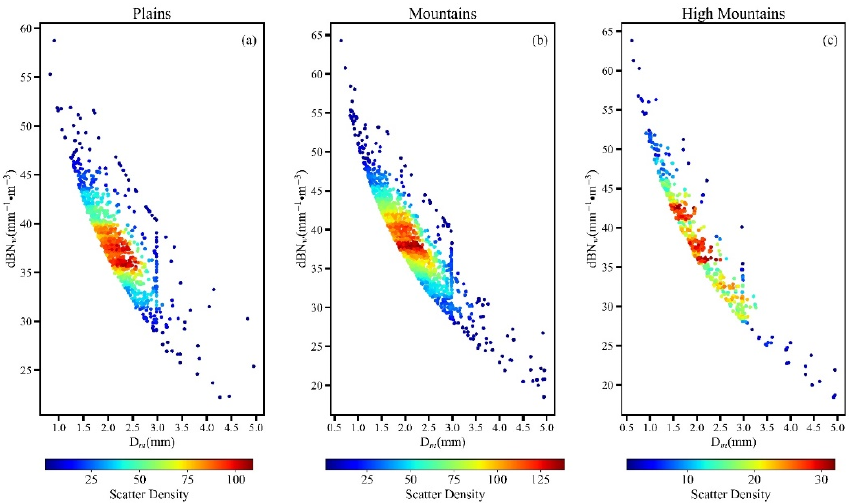
Figure 15. Scatter distribution of near-surface D m -dBN w of heavy CP over plains ( a ), mountains ( b ), and high mountains ( c ). The color indicates the scatter density.